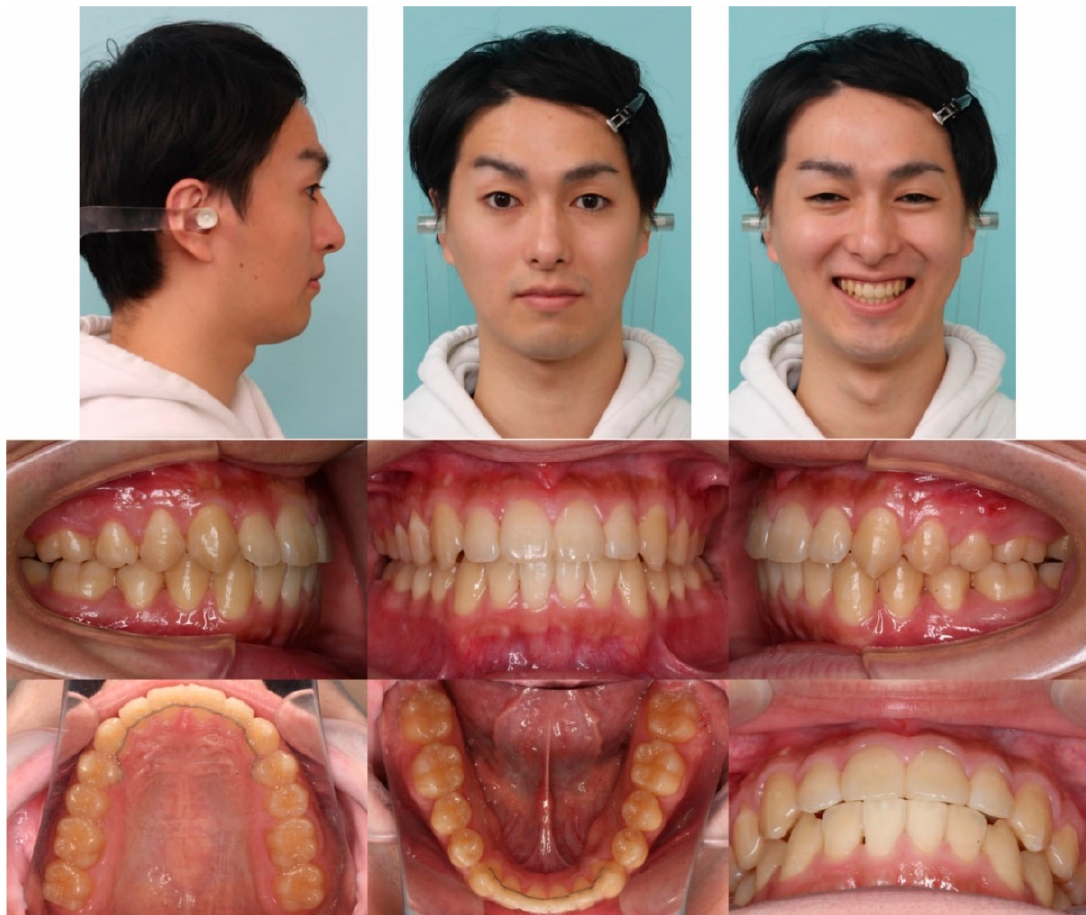
Figure 6. Post-treatment facial and intraoral photographs.